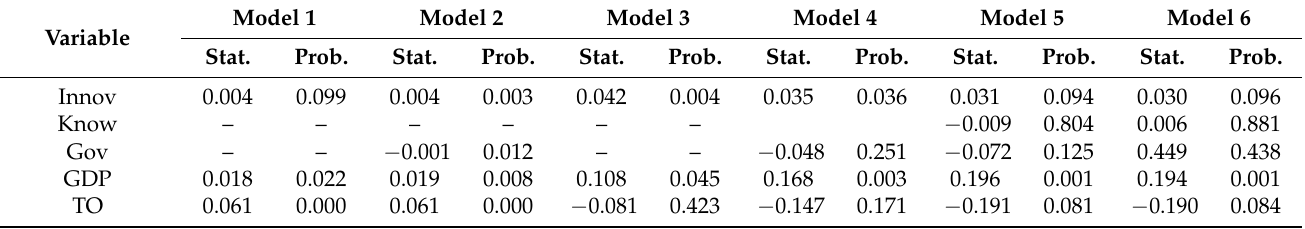
Table 6. The estimation results by heterogeneous parameter models: